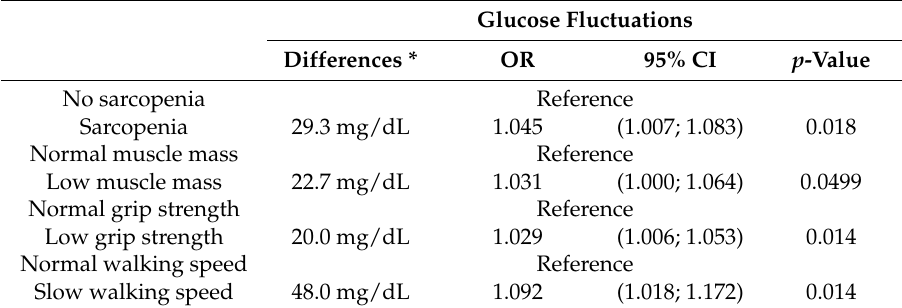
Table 2. Association of glucose fluctuations with